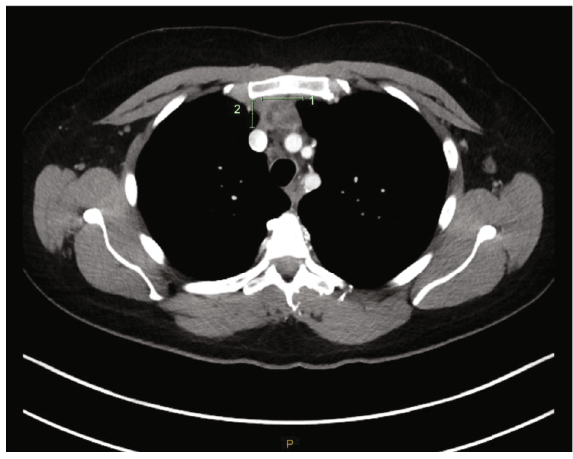
Figure 2: CT scan postchemotherapy treatment showing a reduction in the size of the mediastinal